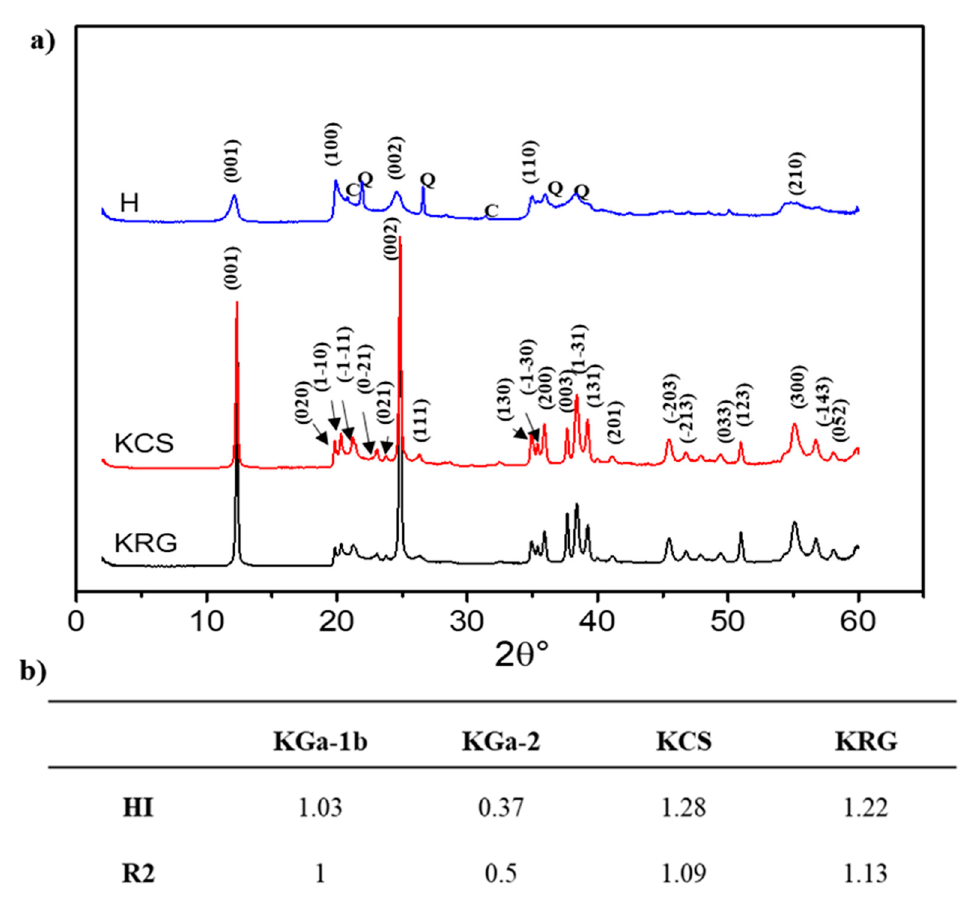
Figure 1. ( a ) X-ray diffraction (XRD) patterns of the raw materials; K: Kaolinite (JCPDS 00-005-0143); Q: Quartz (JCPDS 00-046-1045); H: Halloysite (JCPDS 29-1487); C: Cristobalite (JCPDS 04-008-7642). ( b ) Index of crystallinity (±0.1) of kaolins.